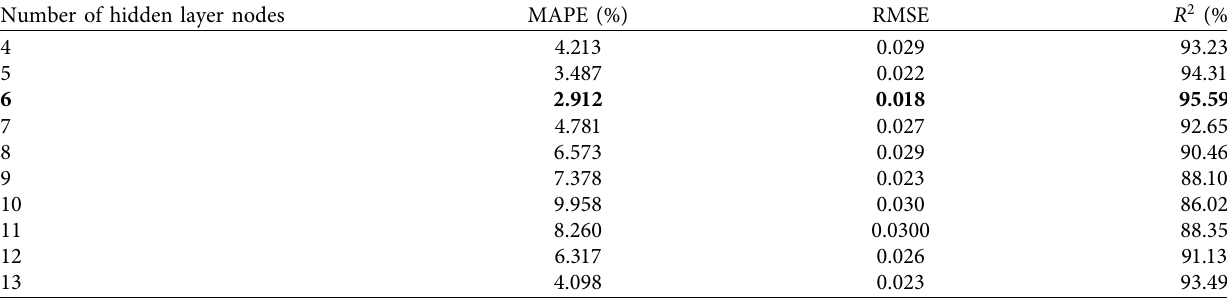
Table 4: Effect of the number of nodes in different hidden layers on the prediction.